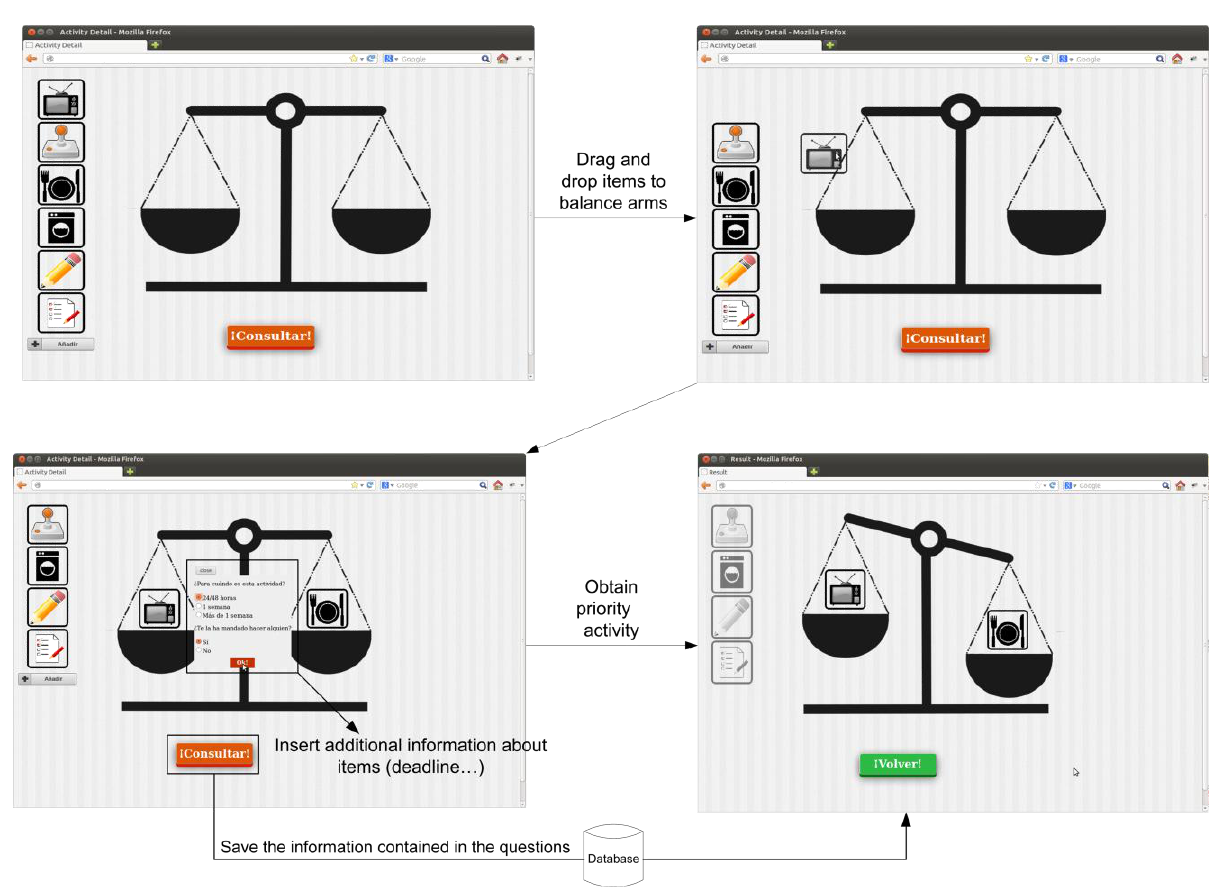
Figure 2. Tool for queries flow.